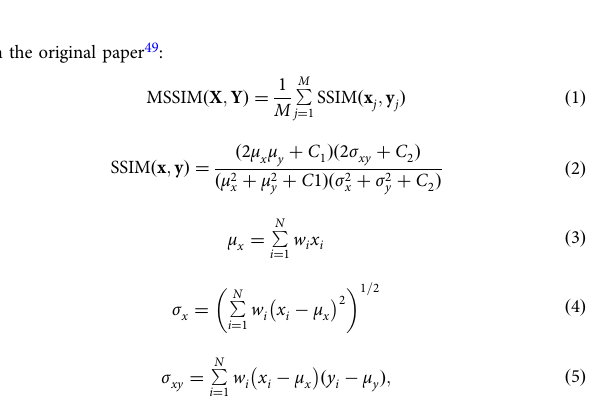
Fig. 5 Application to real data: the Coso Geothermal Field in California. After training our deep autoencoder architecture exclusively on synthetic InSAR time series of point sources of deformation corrupted with atmospheric noise, we apply it to the time series obtained from Sentinel 1A – B from 14 April 2016 to 16 November 2016, which spans the Coso Geothermal Field in California. Our model detects a transient episode of subsidence of 5 – 7 mm (in line of sight), where the operational wells are located, with no a priori knowledge of the area. a Geographic setting with the coverage of the subset of the Sentinel 1 track used here. Red and blue dots indicate the geothermal wells, respectively, for injection and production. b Input raw time series of nine successive images from Sentinel 1 data. Color is the apparent range change between the satellite and the ground along the LOS. c Denoised cumulative deformation as output by our deep autoencoder. Color is ground deformation in the LOS. The thin dashed line indicates the location of the cross-section shown in